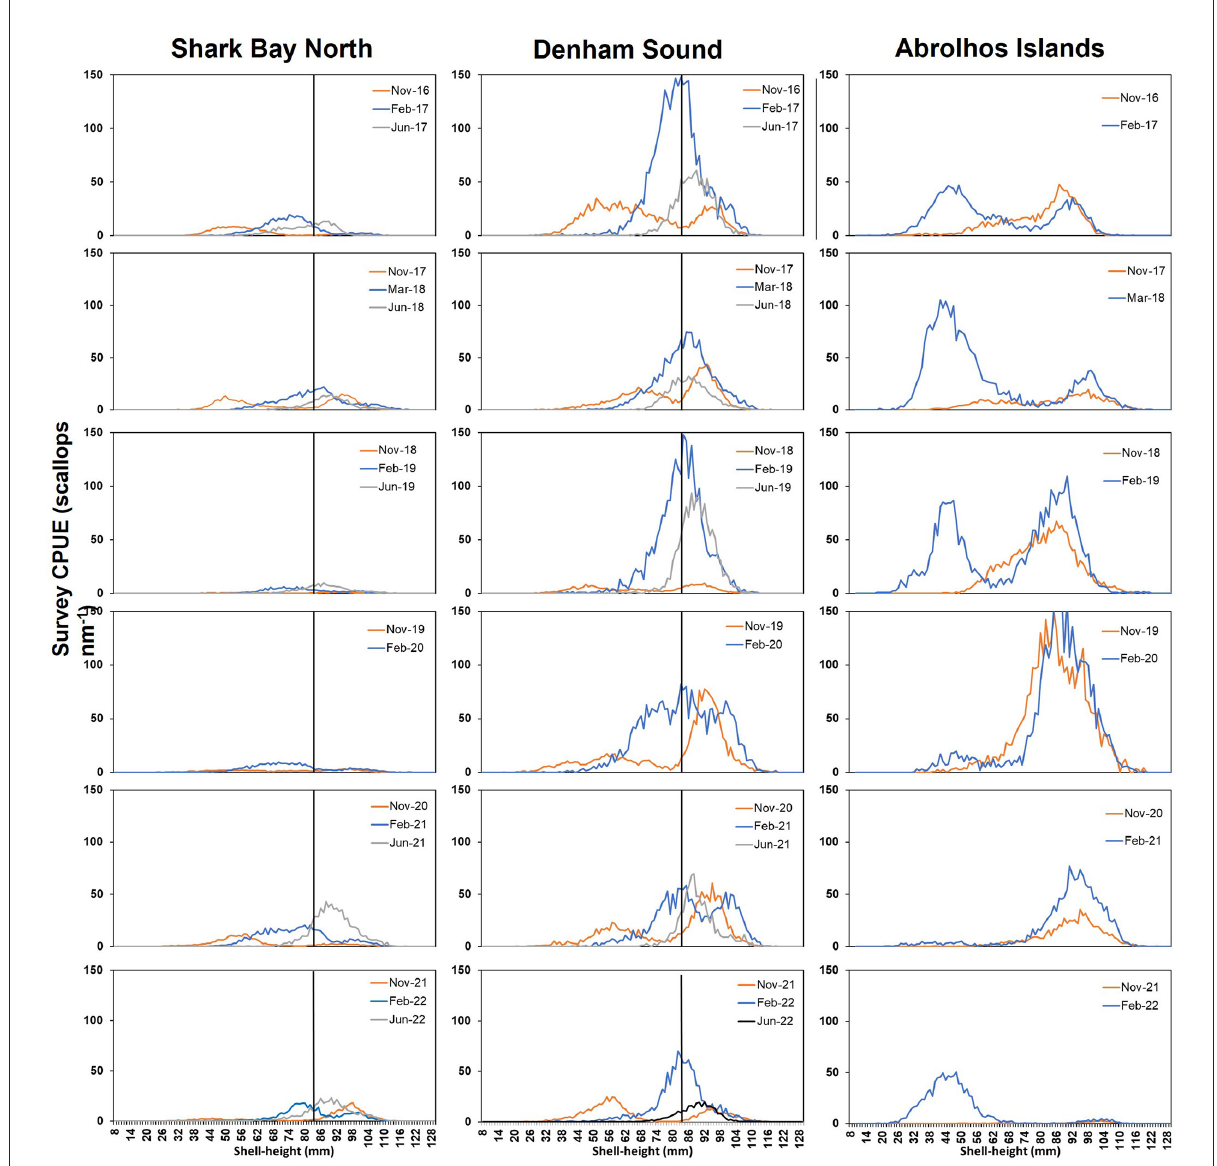
FIGURE8 Shell-height (mm) frequencies from November, February and June surveys between 2016 and 2022 in Shark Bay North (left) , Denham Sound (middle) and at the Abrolhos Islands (right) (no June surveys undertaken at the Abrolhos Islands and no June 2020 in SB). The size of 83mm shell height (black vertical line) which represents the average cut off between 0 + and 1 + during the November survey in